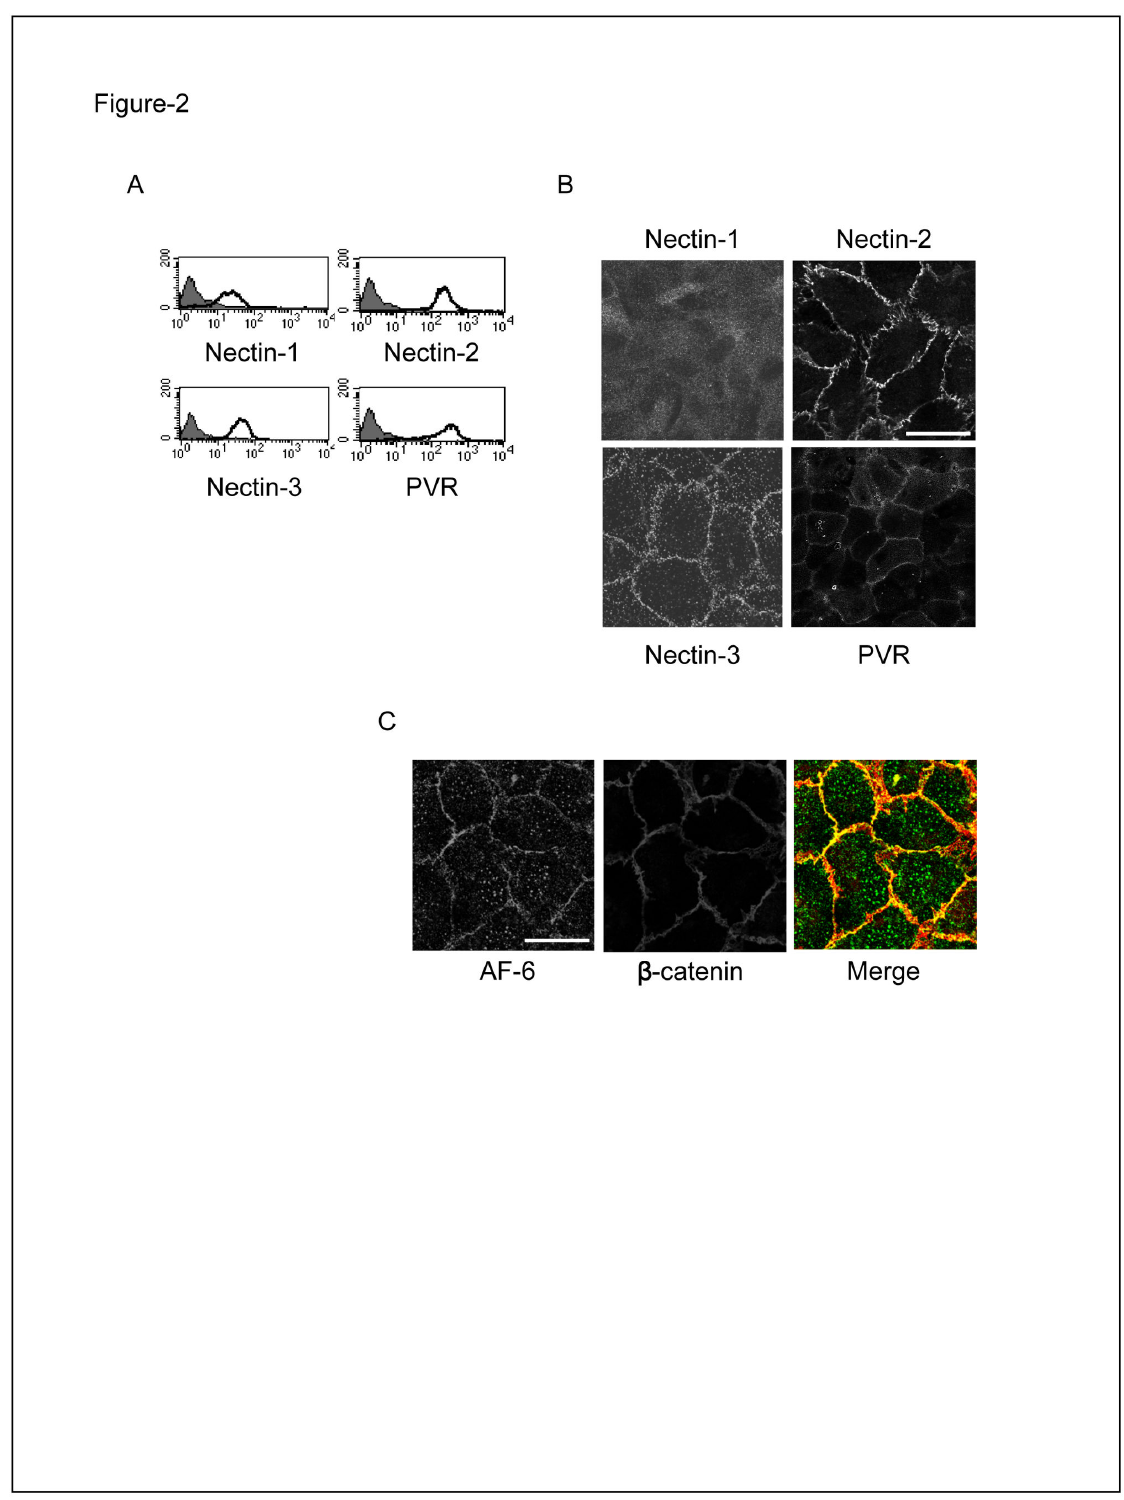
Figure 2. Nectins are expressed on primary ECs. HUVEC confluent monolayers were analyzed by FACS ( A ) and immunofluorescence ( B ) with anti-Nectin-1 (R1.302), anti-Nectin-2 (R2.477), anti-Nectin-3 (N3.12), anti-PVR (PV.404) and ( C ) with anti-AF-6 and anti-β-catenin mAbs. Bar, 50 µm. doi: 10.1371/journal.pone.0077424.g002 PLOS ONE |